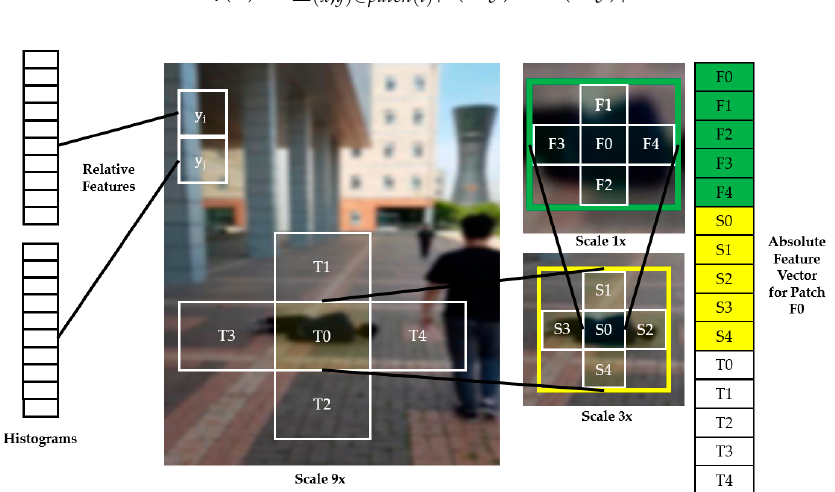
Figure 2. Absolute (the right-hand side) and relative depth features (the left-hand side) used for estimating scene global depth (see [32] for details).